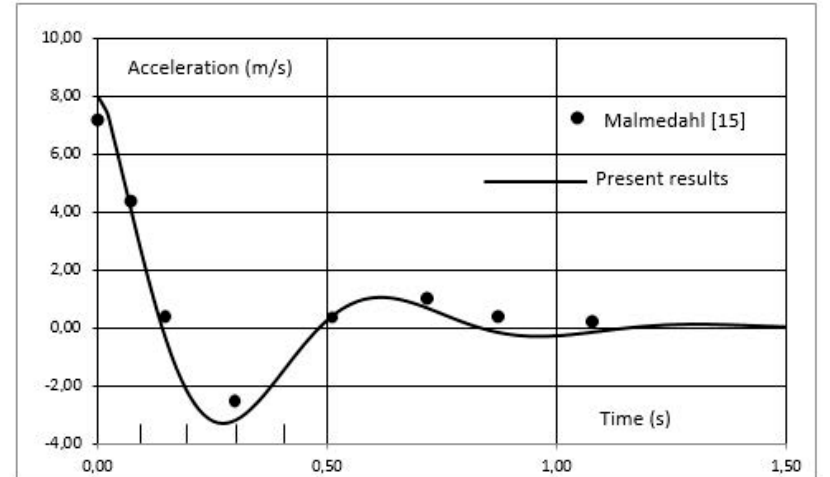
Figure 9. Acceleration at the wheel of a vehicle tire and suspension set hitting the soil suddenly from a small height. Points were collected from Malmedahl [13] having shifted them of about 0.1 s so that the starting point could match approximately the corresponding results here evaluated.